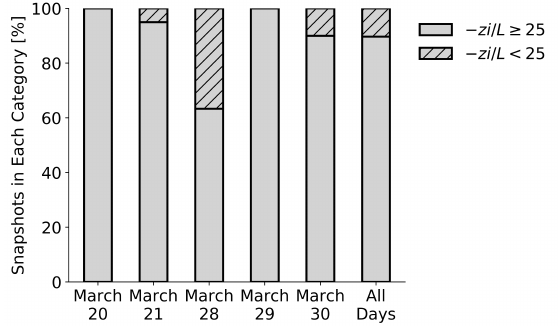
Figure 5. Percentage of simulation snapshots that falls into each of two categories: instability parameter − z ≥ 25 (convective cell regime) and − z i / L each simulated day and for all days